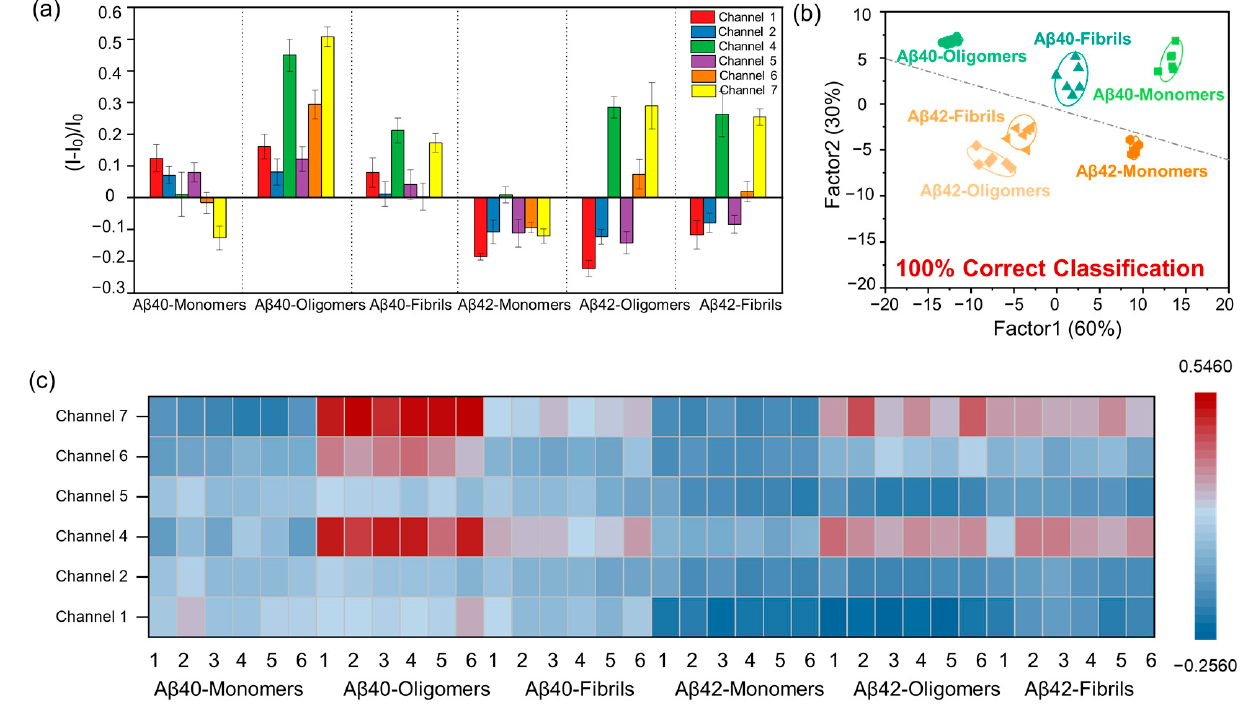
Figure 4. ( a ) Fluorescence response pattern (I − I 0 )/I 0 obtained by optimized 6-channel sensor array against A β 40/42 proteins (1 µM) in serum, error bars indicate the standard deviation (SD) of six replicates. ( b ) Canonical score plot for the first two factors of fluorescence patterns obtained from the optimized 6-channel sensor array with A β 40/42 proteins in serum. The scores were generated through LDA with 95% confidence ellipses. ( c ) Six-channel heat map of the fluorescence response of A β 40/42 protein in serum. Six replicates are shown for each protein.